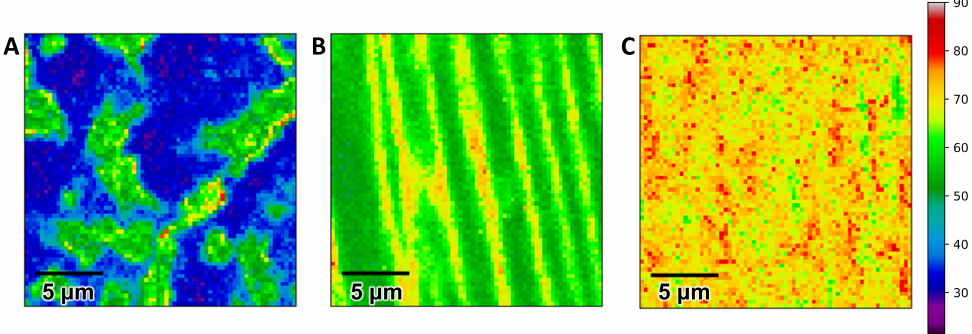
Figure 2. 20 × 20 µ m 2 maps of the Raman 2D peak FWHM for unmodified ( A ) monolayer, ( B ) hydrogen-intercalated QFS bilayer, and ( C ) multilayer